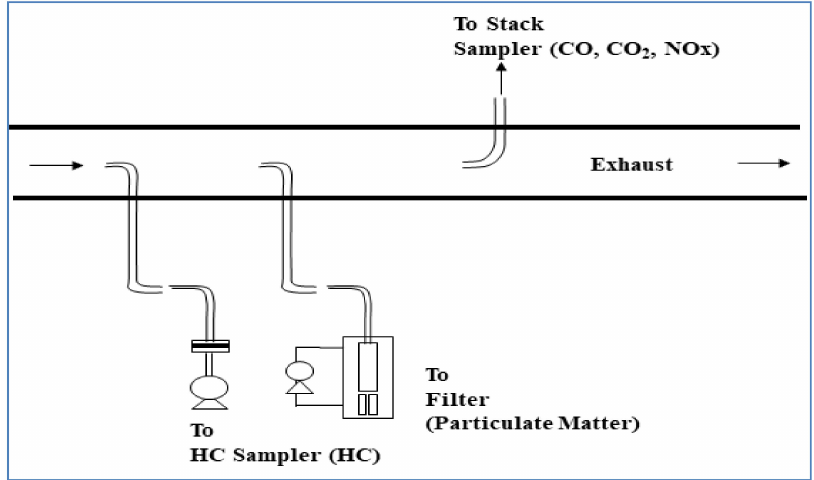
Figure 1. Schematic of the exhaust sampling and dilution system.